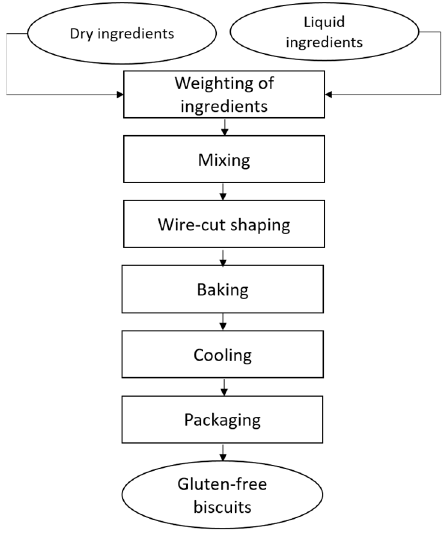
Figure 1. Flow chart of biscuit production process.